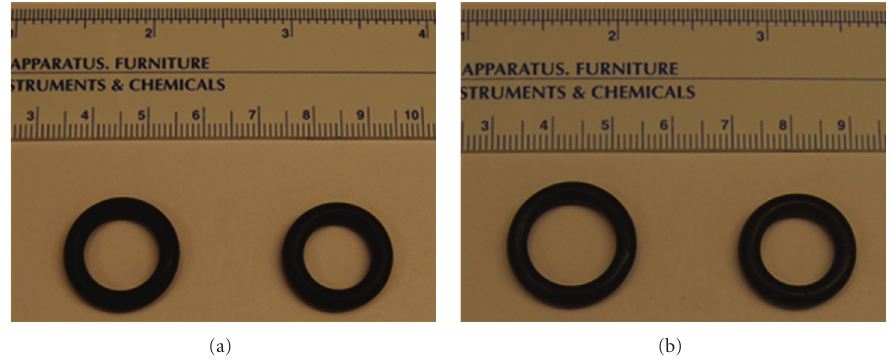
Figure 6: Change in internal diameter ( Δ ID) for (a) EPDM and (b) Buna-N